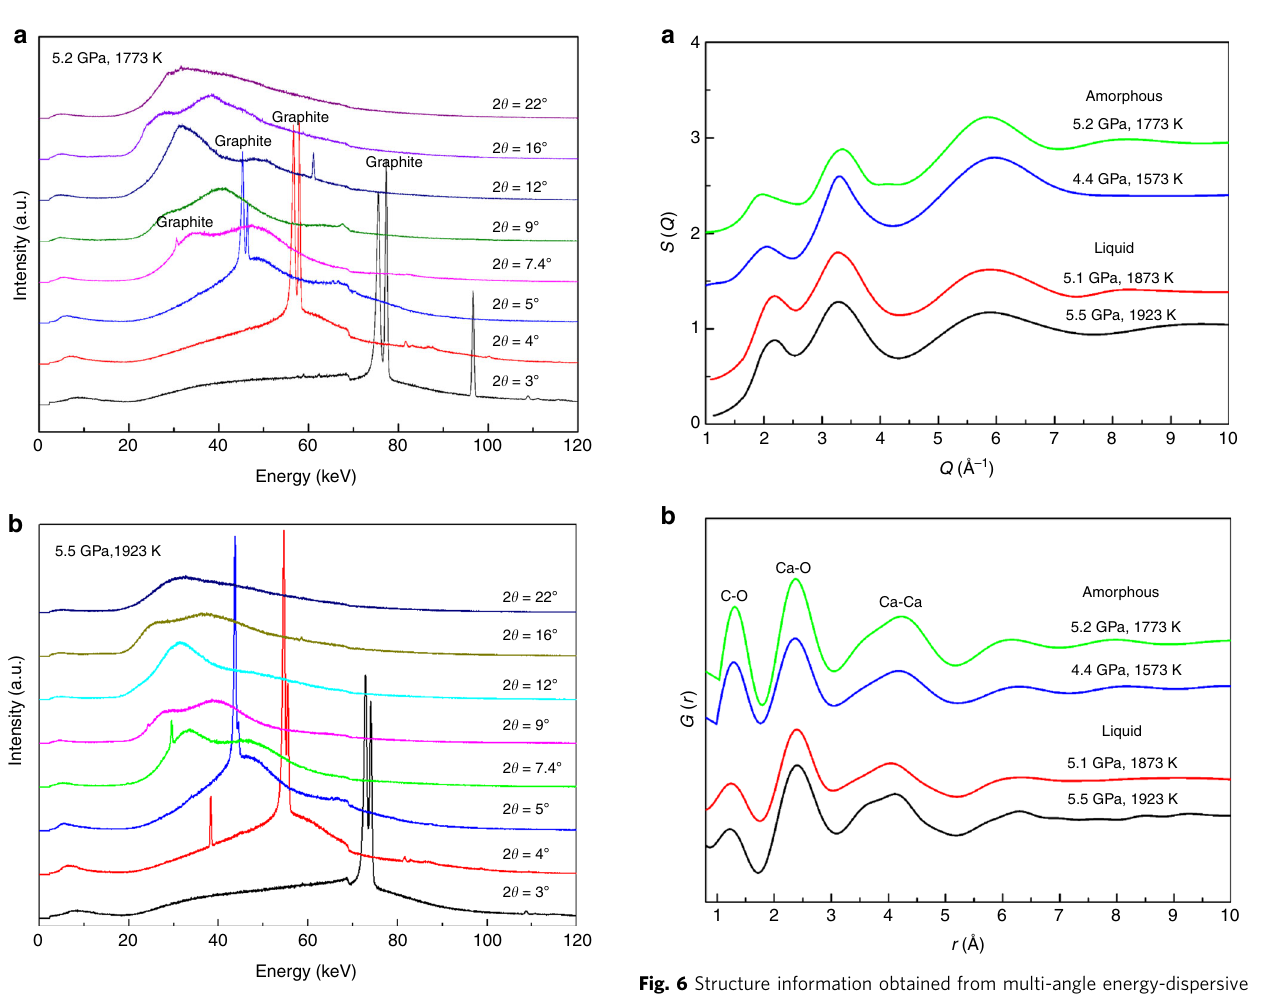
Fig. 5 Multi-angle energy-dispersive X-ray diffractions of CaCO 3 . a Amorphous CaCO 3 at 5.2 GPa and 1773 K; b Liquid CaCO 3 at 5.5 GPa and 1923 K. The liquid state was determined by the falling of Pt sphere. Two sharp peaks at 61.114 keV (2 θ = 12°) and 96.640keV (2 θ = 3°) with d = 0.970(1)Å and d = 2.450(1) Å in a are from MgO. The sharp peak at 38.279 keV (2 θ = 4°) with d = 4.640 (1) Å in b may come from other